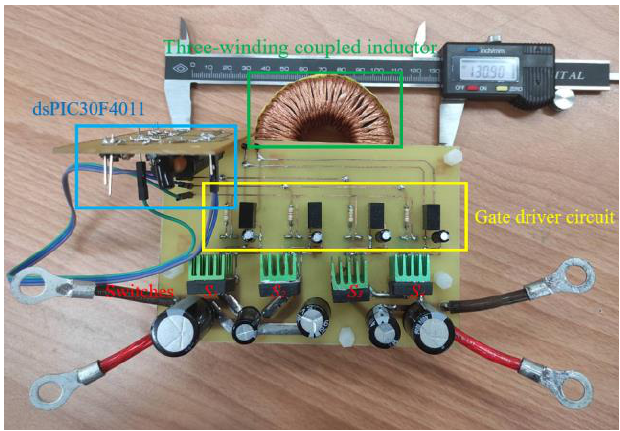
Figure 12. Photograph of the proposed topology.